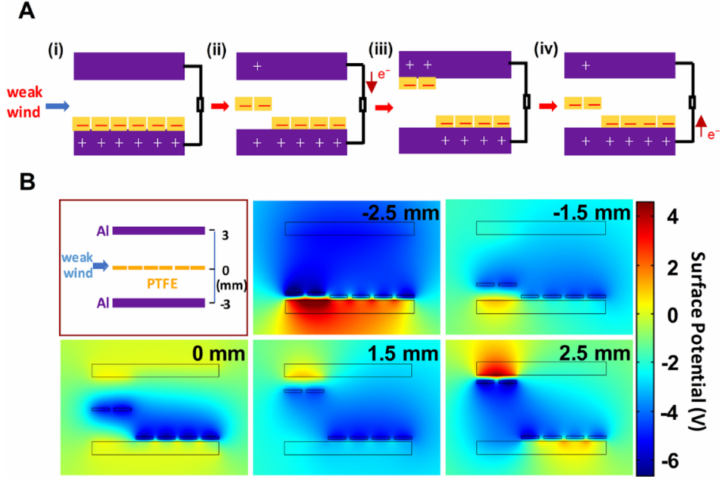
Figure 2. ( A ) Working mechanism of the wind-TENG ( B ) Finite-element simulation of the surface potential variation for